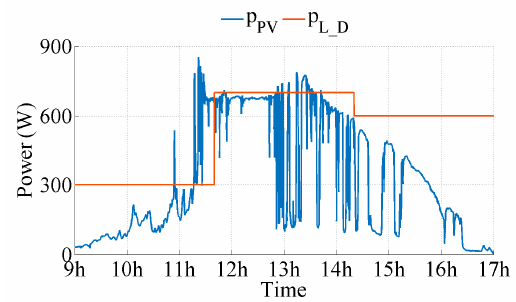
Figure 5. PV power profile of 6 November 2014 and load power profile.